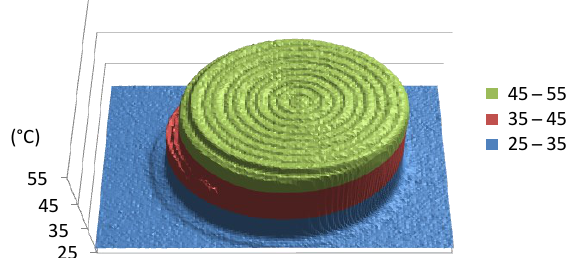
Figure 22. Temperature distribution on the active blackbody surface.